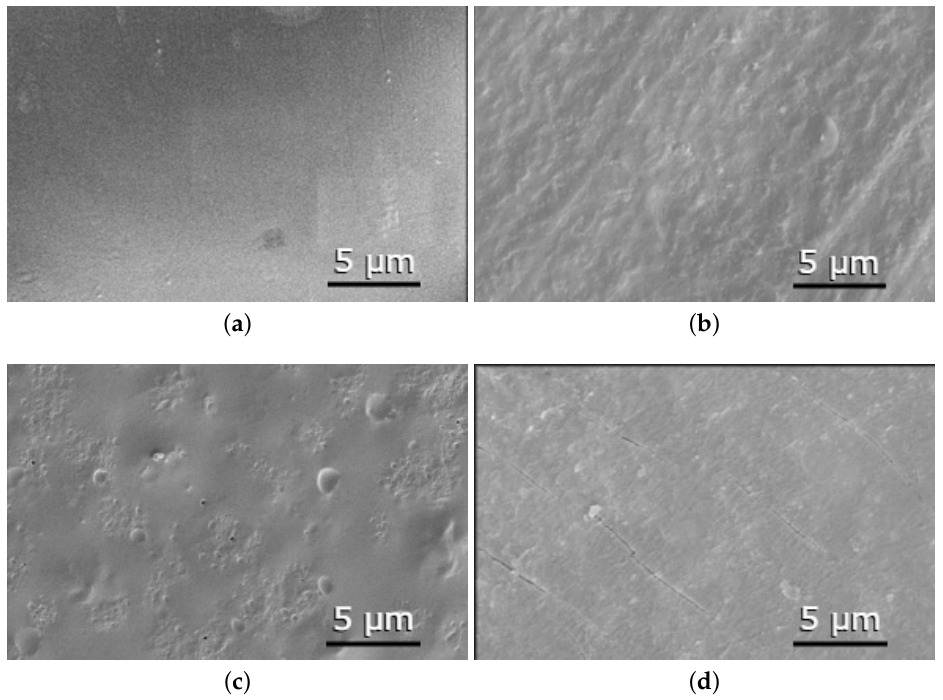
Figure 7. Scanning electron microscopy of samples: ( a ) non-impregnated PLA (5000 × ), ( b ) impregnated at 3% of ethanol, P = 100 bar, T = 35 ºC (5000 × ), ( c ) impregnated at 1% of MLE, P = 100 bar, T = 35 ºC (5000 × ), ( d ) impregnated at 3% of MLE, P = 100 bar, T = 35 ºC (5000 ×